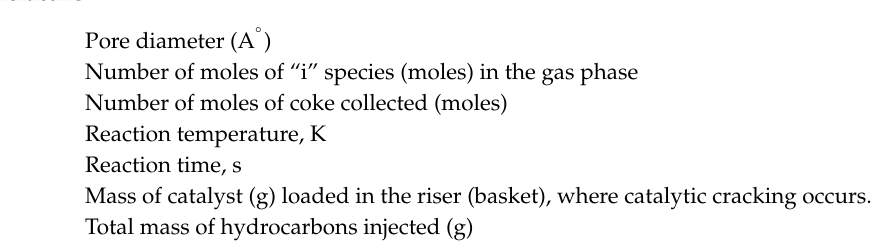
Figure S1: BET-Nitrogen Adsorption Plot. N 2 adsorption-desorption isotherms obtained from di ff erent samples of CAT-C, after runs at 550 ◦ C and a 7 s contact time. Figure S2: Di ff erential Pore Volume (dV / dD) as a Function of the Pore Diameter (D) using the N 2 -Adsorption Isotherms. ( (cid:4) ) CAT-C free of coke; ( (cid:8) ) CAT-C at C / O = 0.6g / g; ( (cid:78) ) CAT-C at C / O = 0.8g / g; ( (cid:72) ) CAT-C at C / O = 1.25 g / g; ( (cid:7) ) CAT-C at C / O = 2.5 g / g ( (cid:74) ); CAT-C at C / O = 3.75 g / g; ( (cid:8) ) CAT-C at C / O = 5 g / g; All samples were analyzed following catalytic cracking runs at 550 ◦ C and 7 s. Table S1: Specific Surface Areas [SSA] (m 2 / g) and Pore Volumes [PV] (cm 3 / g). Mesopore Volumes (cm3 / g) for CAT-B are determined following catalytic cracking runs at 550 ◦ C and 7 s, using di ff erent C / O ratios. SD on repeats: +/ − 3 m 2 / g. Figure S3: E ff ect of C / O on the Product Selectivity-M Using TIPB on the Catalyst CAT-C. Run Conditions: 550 ◦ C and 7 s, respectively. Notes: ( a ) Direction of the arrows represent an increasing C / O ratio, ( b ) Reported data and standard deviations (vertical bars) represent average values for 4 − 7 repeat